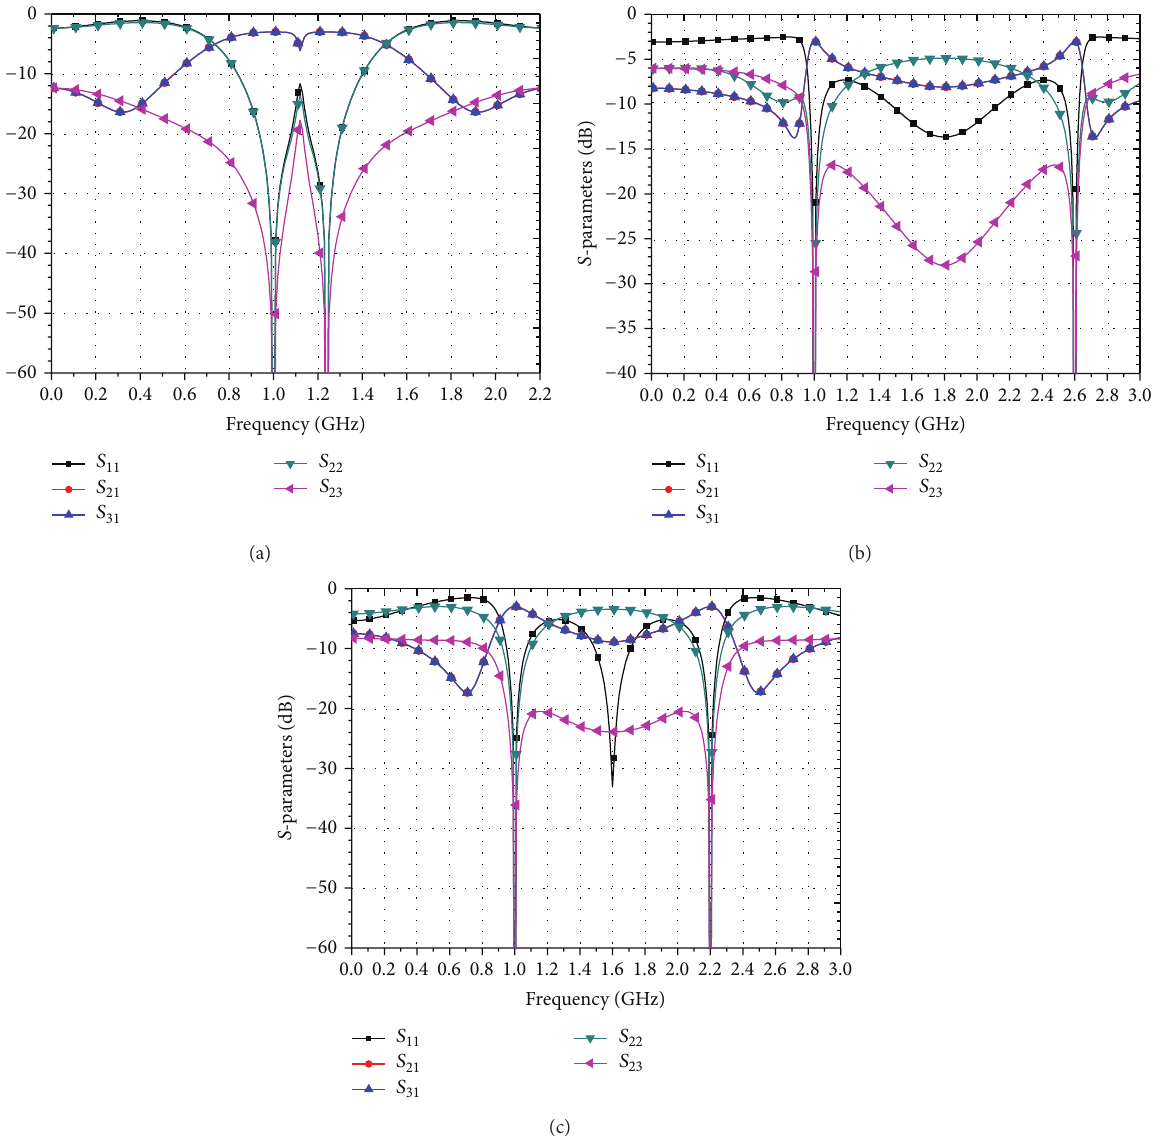
Figure 6: Ideal scattering parameters of three typical dual-band coupled-line power dividers with: (a) 𝑅 𝑆 = 𝑅 𝐿 = 40Ω and 𝑝 = 1.24 ; (b) = 50 Ω , 𝑅 = 30 Ω and 𝑝 = 2.6 ; and (c) 𝑅 𝑅 𝑆 𝐿